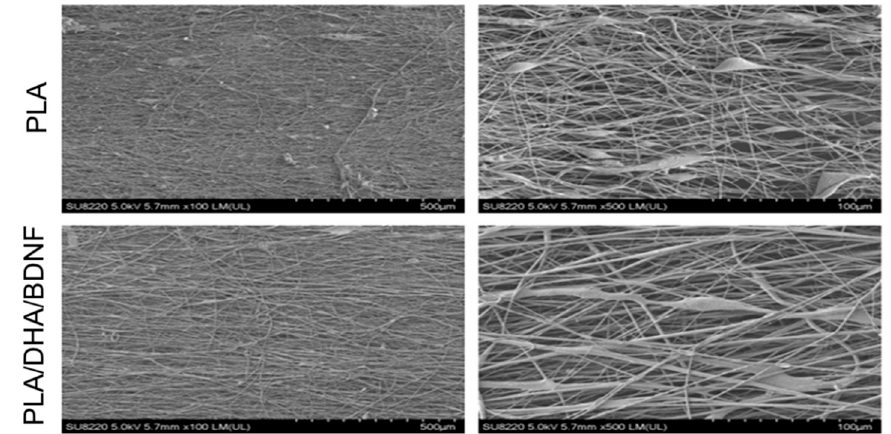
Figure 5. The scanning electron microscopy images of primary neurons cultured on aligned drug-free PLA core–shell fibrous membranes (CSFMs) and drug-loaded PLA/DHA/BDNF CSFMs.